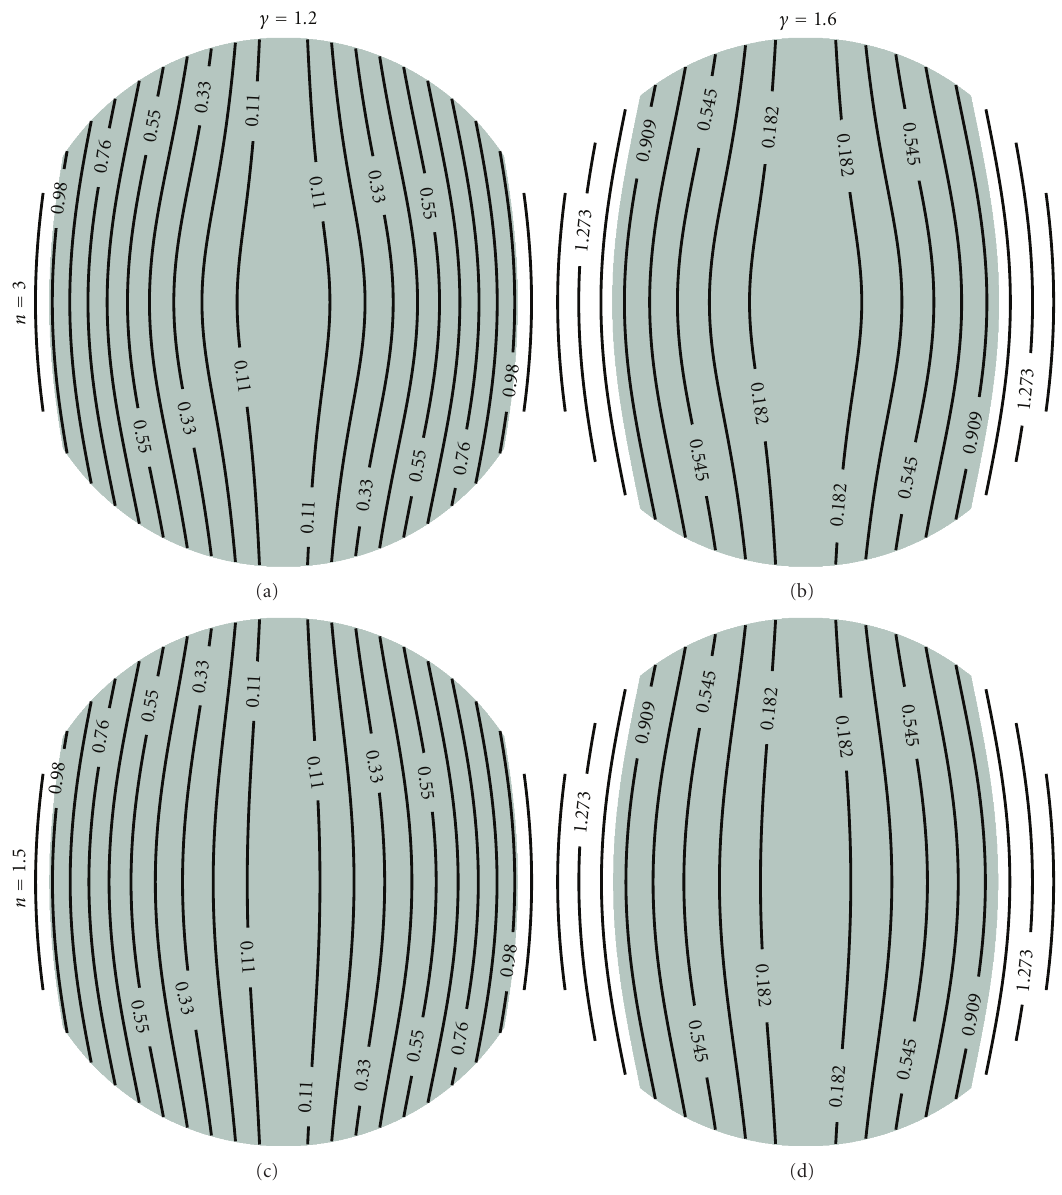
Figure 2: Slices through the perturbed star along the plane parallel to the perturber star’s trajectory. The first column ((a) and (c)) corresp- ond to encounters with γ = 1 . 2, and the second column ((b) and (d)) correspond to γ = 1 . 6. The first row ((a) and (b)) have n = 3, and the second row ((c) and (d)) have n = 1 . 5. The contours are the kick velocity within the star due to the encounter normalized to the escape velocity (as a function of (cid:5) r ). The outline of the grey region underneath has Δ (cid:5) v/ (cid:5) v pd esc ( (cid:5) r ) = 1, so that the grey region represents the location of where mass is still left after the